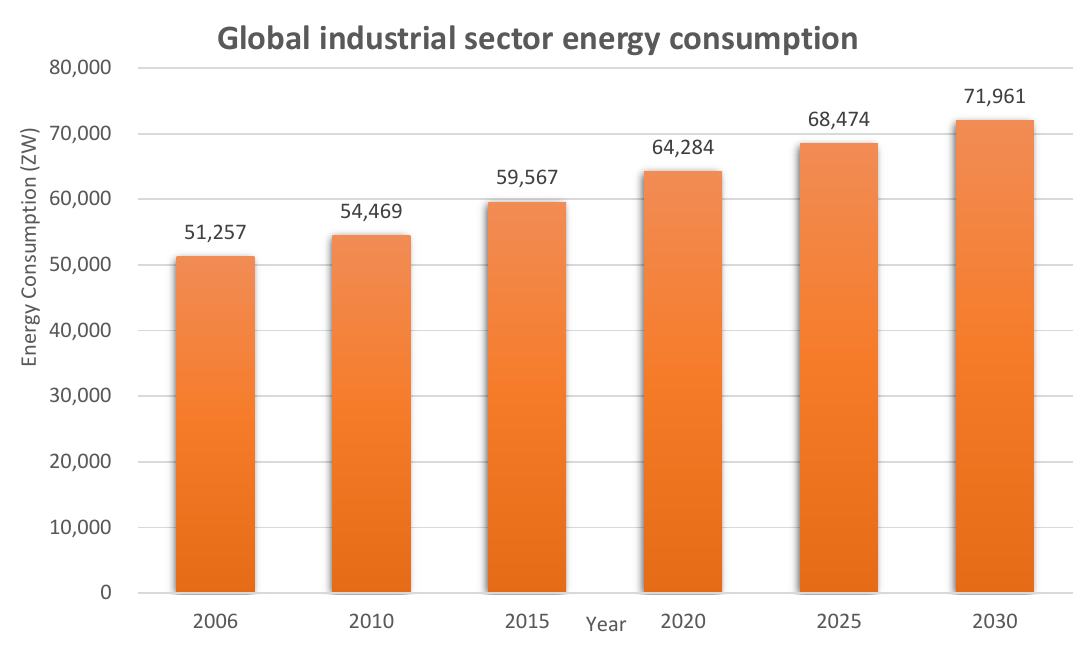
Figure 1. The trend in industrial energy usage until 2030 [6].